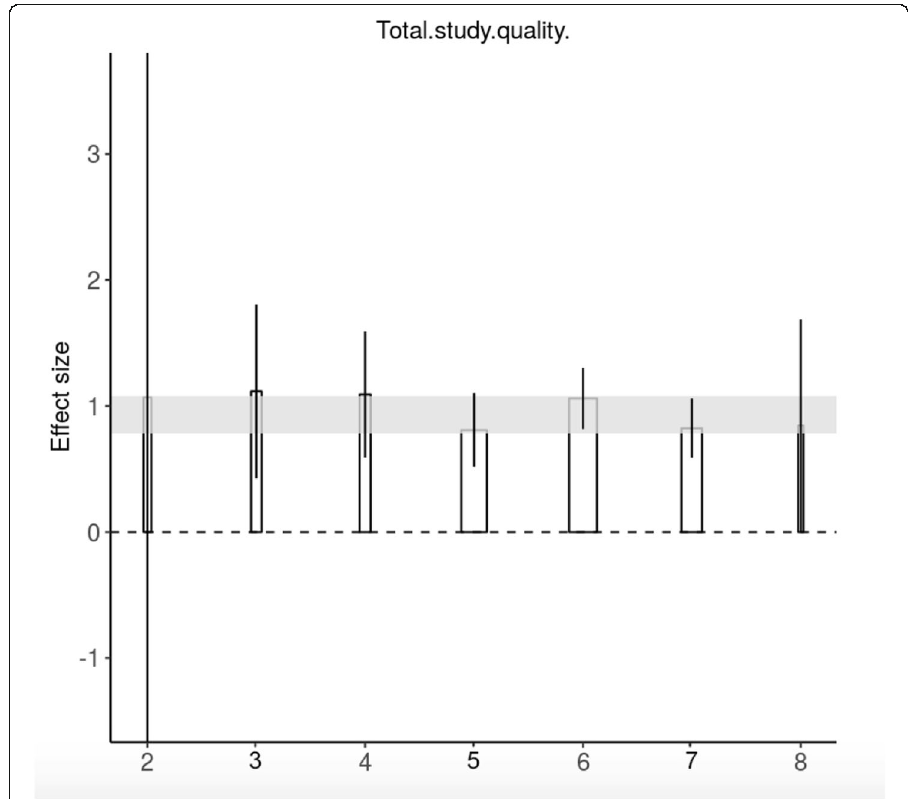
Fig. 3 Number of study quality checklist items scored and point estimates of SMD with 95% confidence intervals (CI) for neurobehavioural outcome. Low numerical checklist score on x axis indicates higher risk of bias. Shaded area is the 95% CI of the global estimate. Thickness of bar reflects number of contributing comparisons. Score ranging from a minimum of 0 to a maximum of 8. SMD = standardized mean